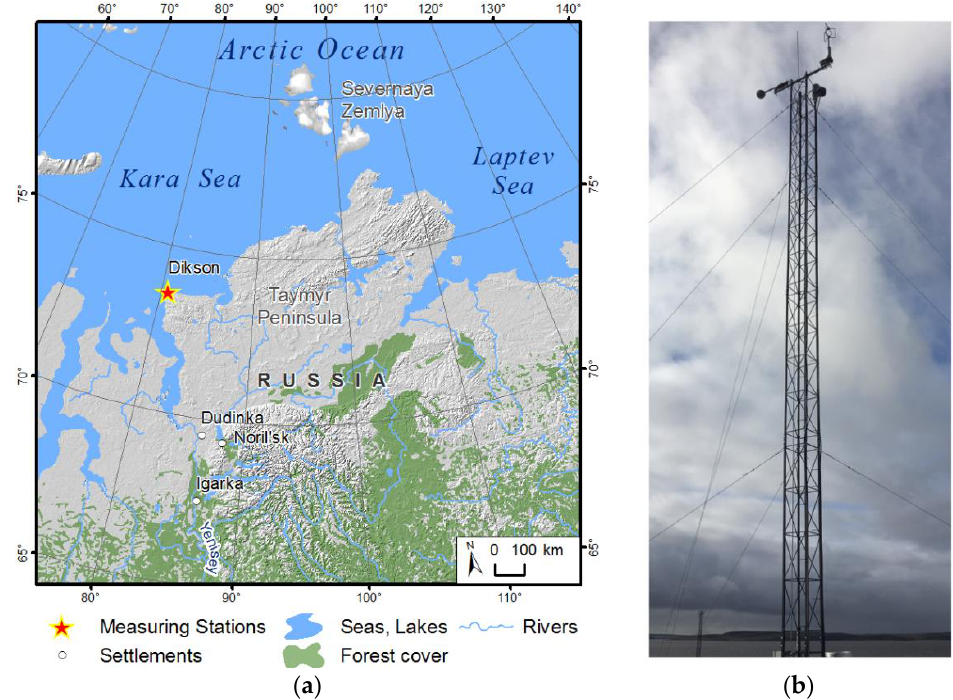
Figure 2. Location of the measurement site at the Gulf of the Yenisei River in the western Taimyr Peninsula ( a ) and a meteorological tower for continuous atmospheric observations ( b ).